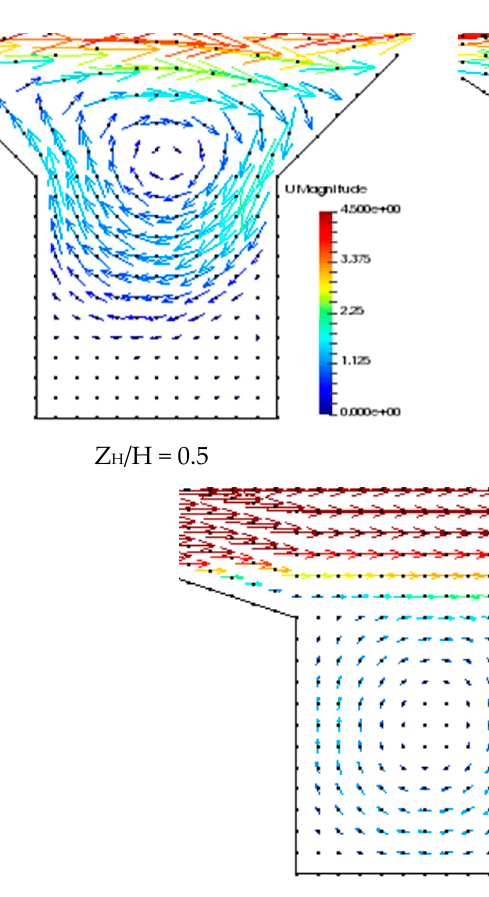
Z H /H = 0.17 Figure 19. Velocity vector of wind flow inside the street canyons with slanted Figure 19. Velocity vector of wind flow inside the street canyons with slanted roofs.